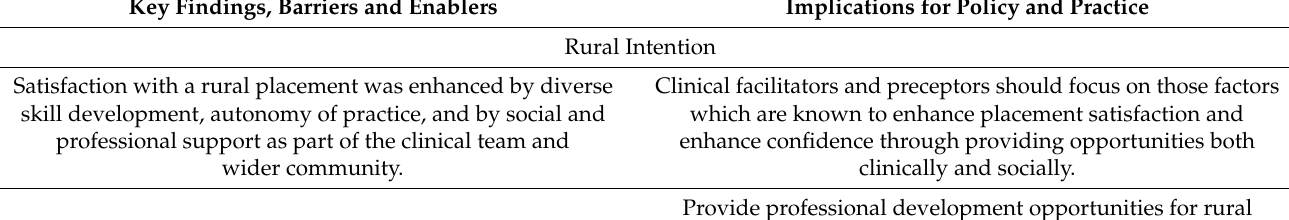
Table 2. The key findings of this study, along with their implications for policy and